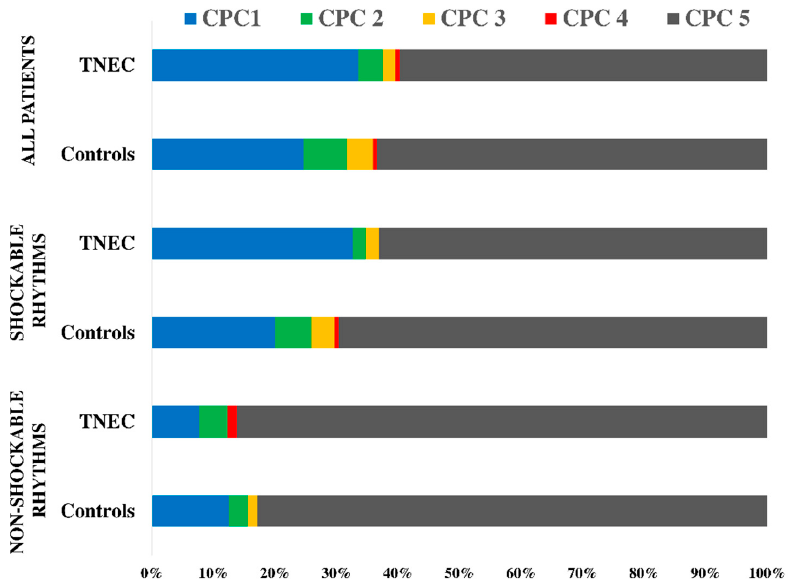
Figure 3. Cerebral Performance Score (CPC) at 6-month distribution between study groups in the subgroup of patients with shockable (ventricular fibrillation or pulseless ventricular tachycardia) and non-shockable (asystole and pulseless electric activity) initial rhythm.